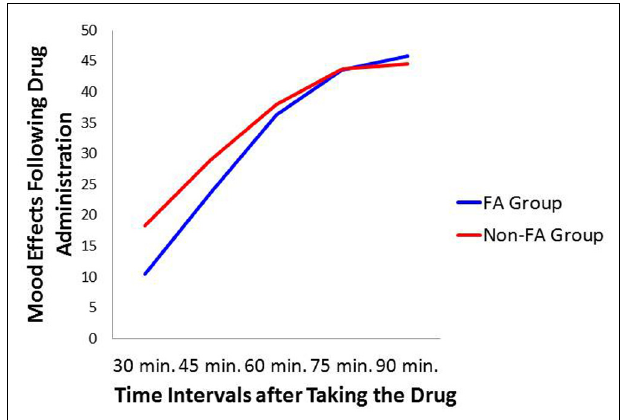
FIGURE 5 | Plot for the Diagnostic Group × Time Interval relationship with mood ratings on the drug day as the dependent variable.